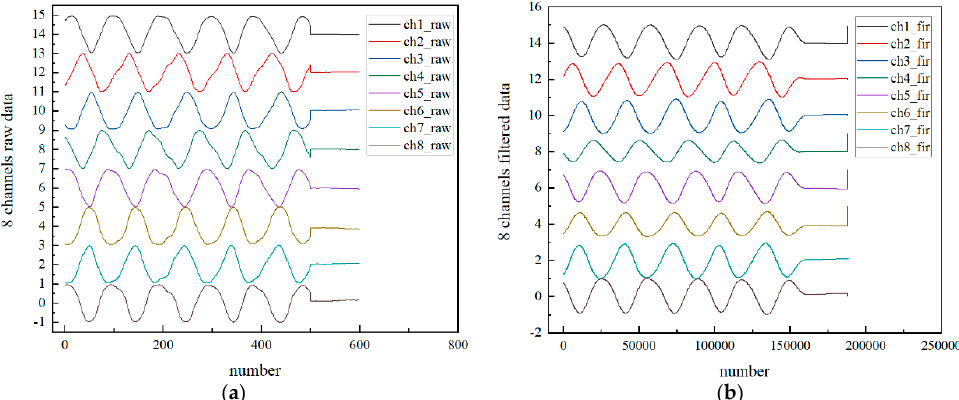
Figure 5. ( a ) Data acquired by AD and ( b ) FIR-filtered data.